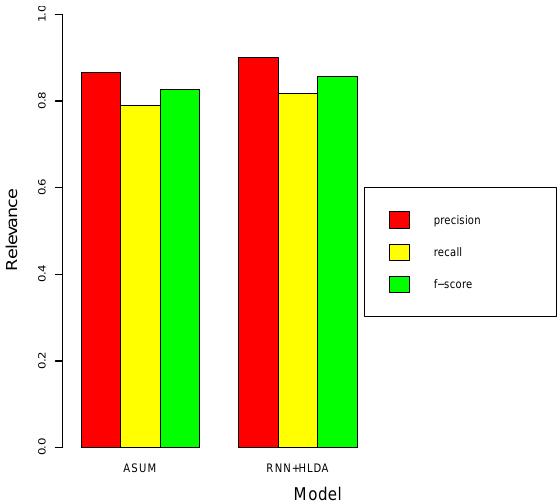
Figure 3. Relevance comparison under the joint model and